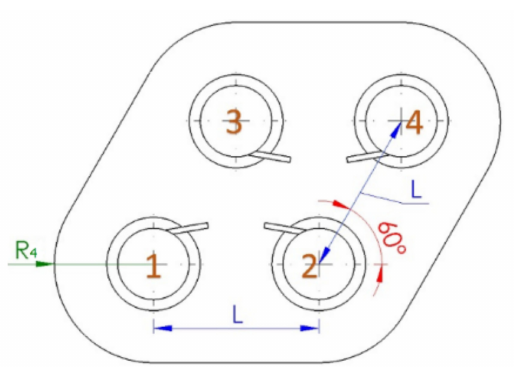
Figure 5. Dual-vortex grippers.